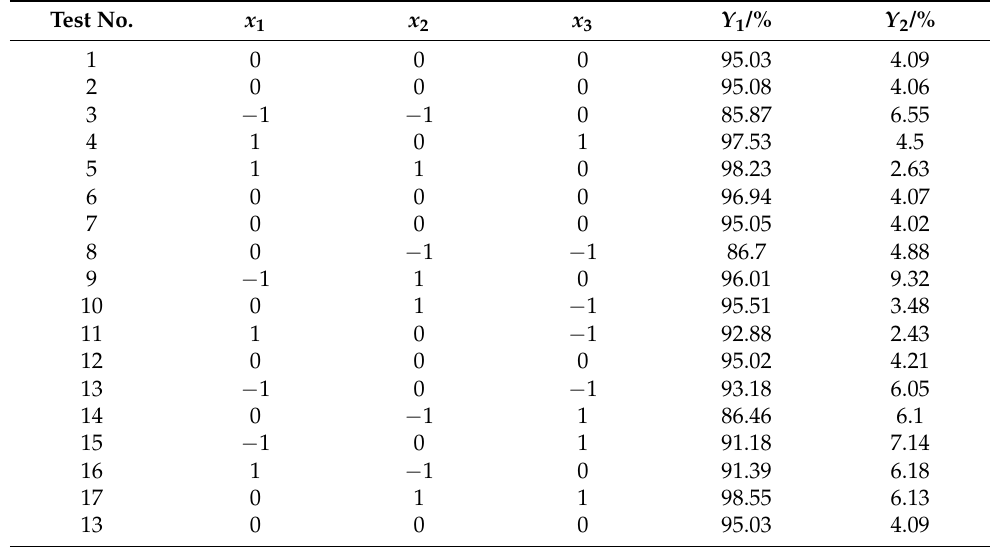
Table 3. Test scheme and its